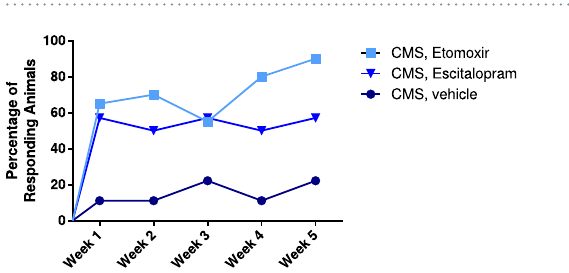
weeks compared to baseline prior to onset of treatment. The effect of treatment with Etomoxir and Escitalopram was almost the same in week one and three, whereas the percentage of responding rats to Etomoxir treatment was higher than Escitalopram treatment in week two, four and five. Treatment with Escitalopram showed 57%